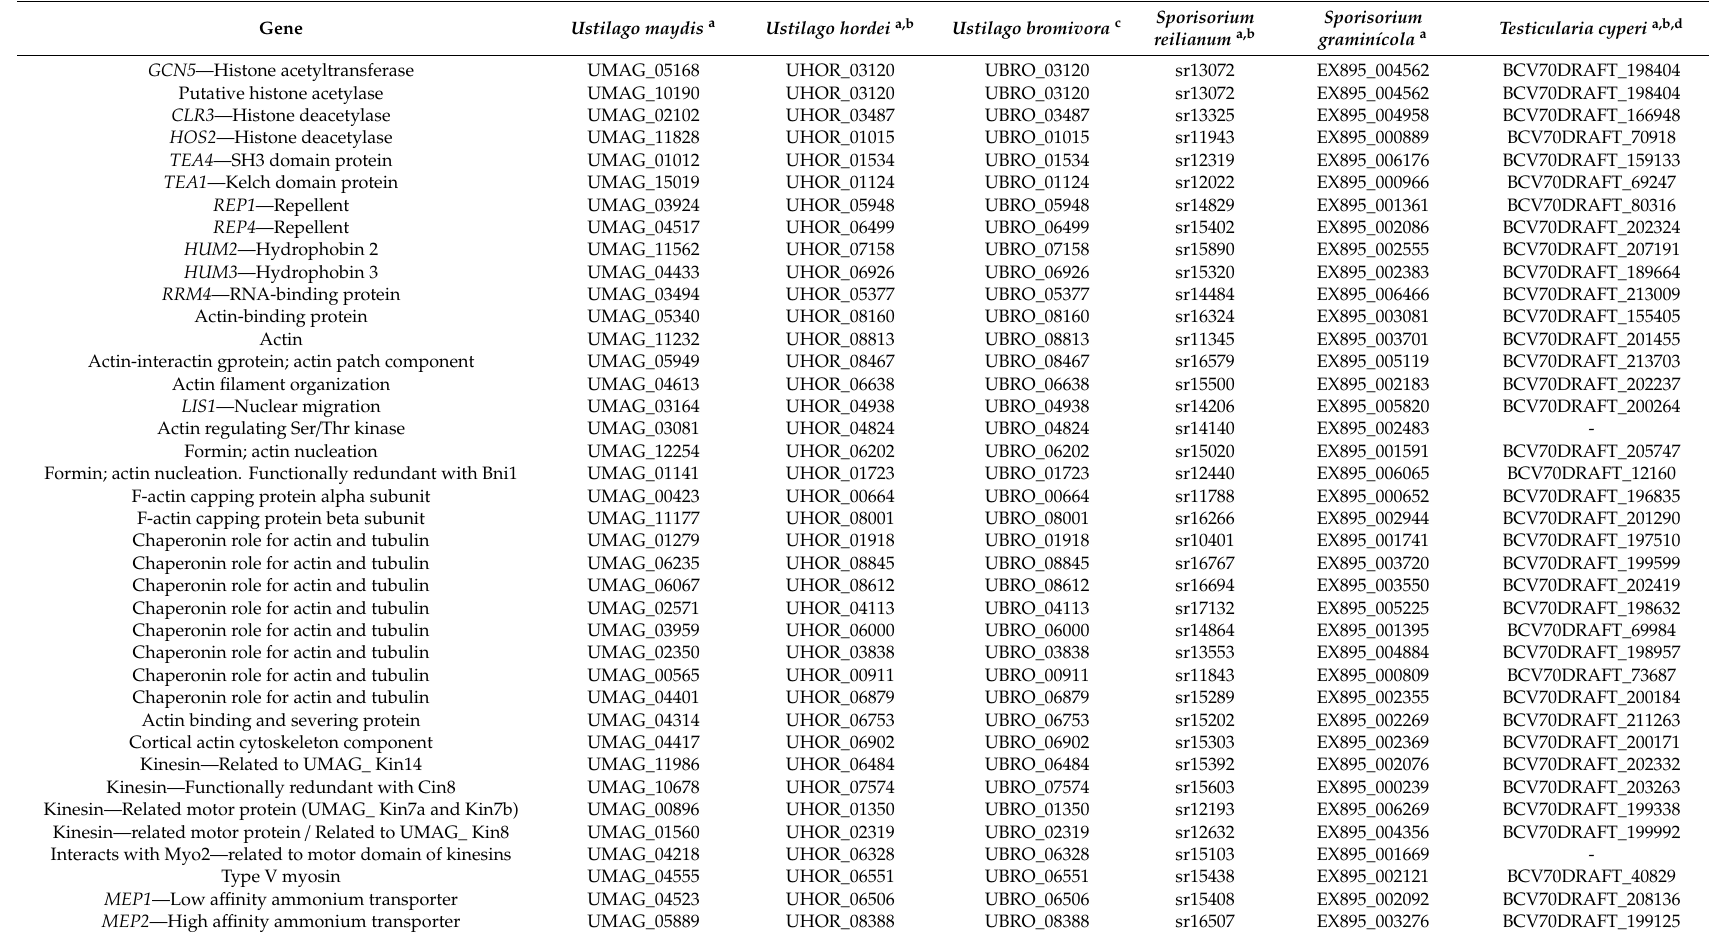
Table 3. Genes described as related with the multicellular growth of